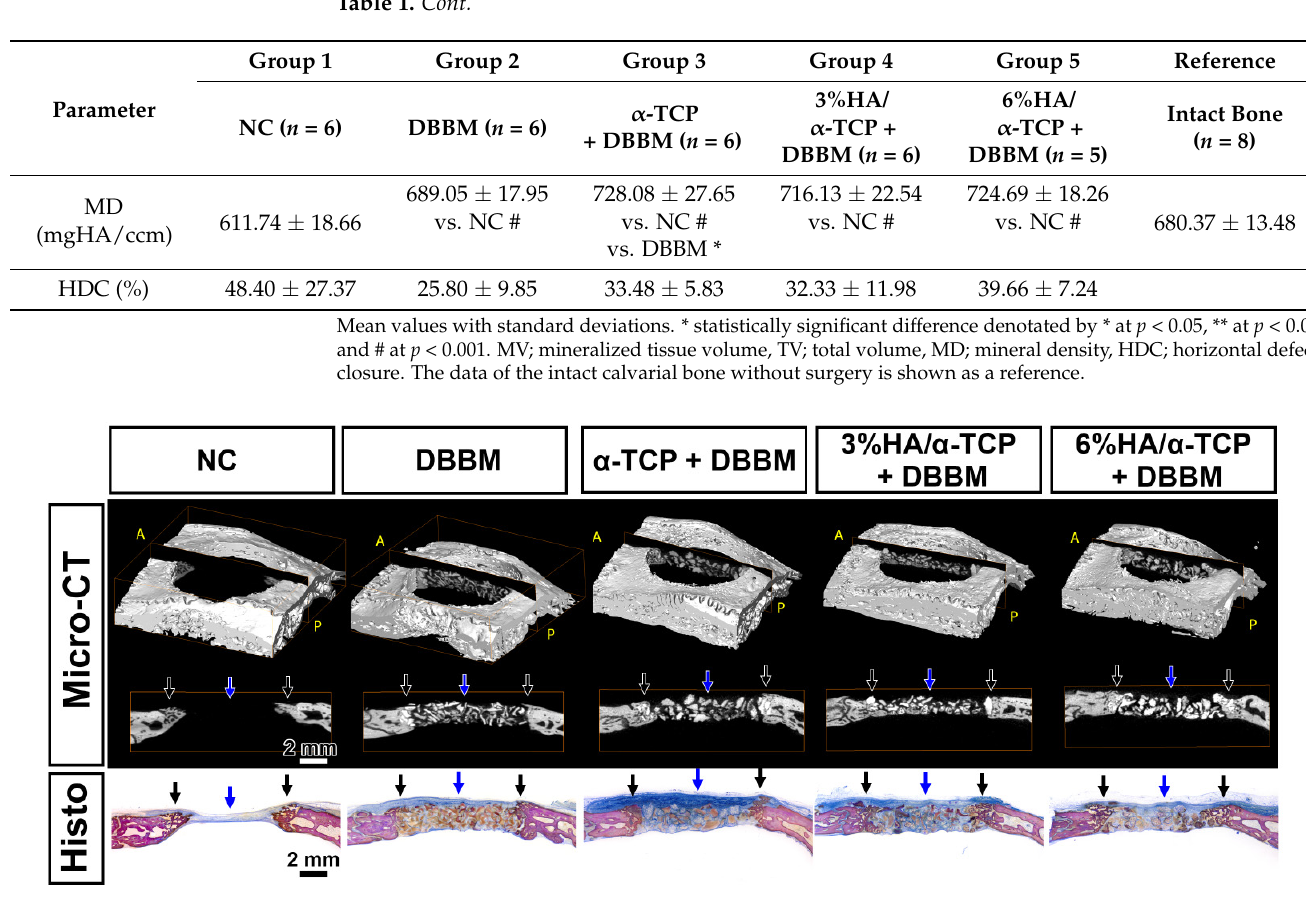
Figure 3. Sagittal sections of the micro-CT images and the corresponding toluidine blue and fuchsin staining at 4 weeks. All groups presented new bone in the peripheral areas (black arrows), and minor mineralized bone formation with abundant connective tissues surrounding to the materials were observed in the central areas of the defects (blue arrows). (Scale bars: 2 mm, A: Anterior, P: Posterior). Table 1. Quantified micro-CT values in a 10-mm defect VOI (VOI_1).